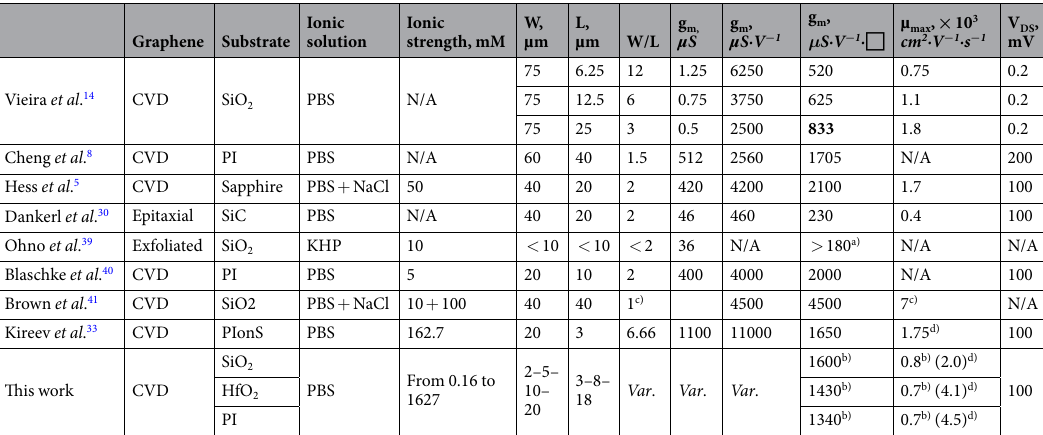
Table 1. An overview of liquid gated graphene transistors used in literature. a) Calculated with the assumption V DS = 100 mV; b) given the mean values only; c) Hall bar structure; d) given the maximum value recorded for one of the